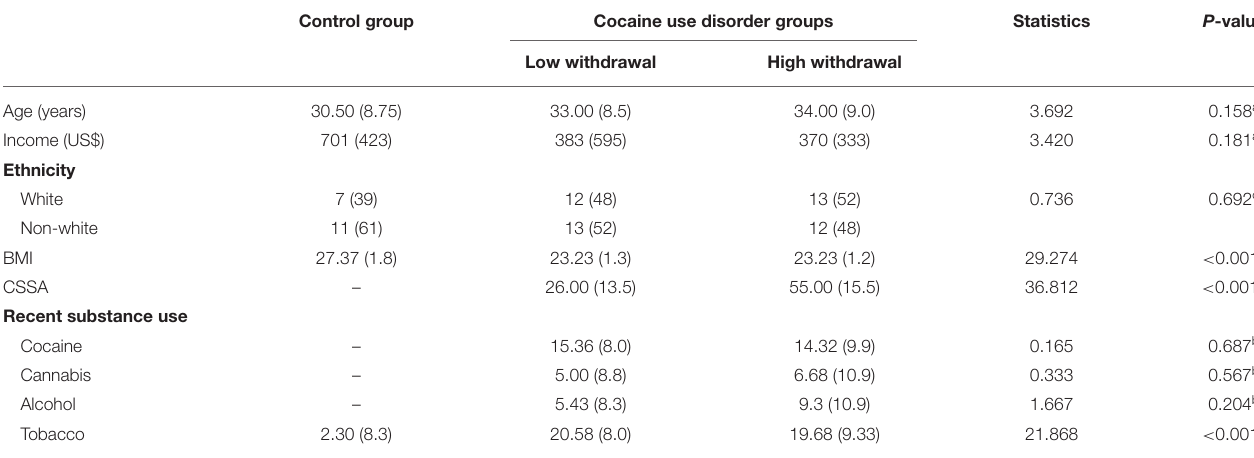
TABLE 1 | Demographic and clinical